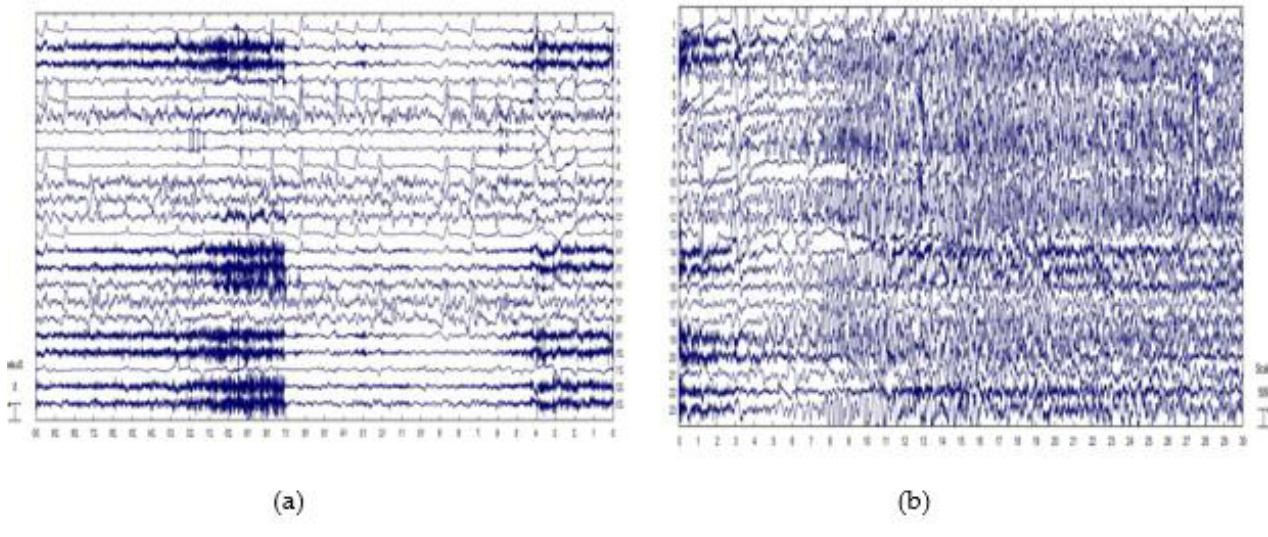
Figure 2. CHB-MIT database: examples of ( a ) non-seizure record; ( b ) seizure record.